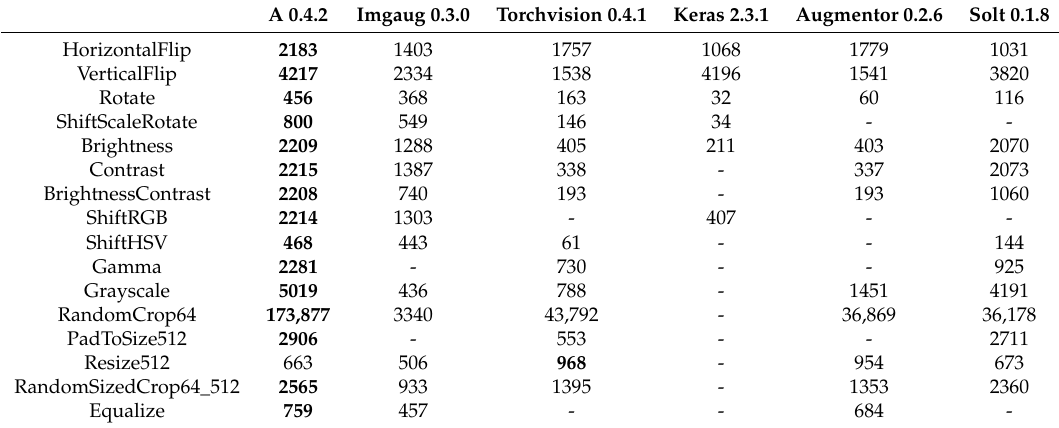
Table 1. Results for running the benchmark on the first 2000 images from the ImageNet validation set using an Intel Xeon Platinum 8168 CPU. All outputs are converted to a contiguous NumPy array with the np.uint8 data type. The table shows how many images per second can be processed on a single core (higher is better). A denotes results for